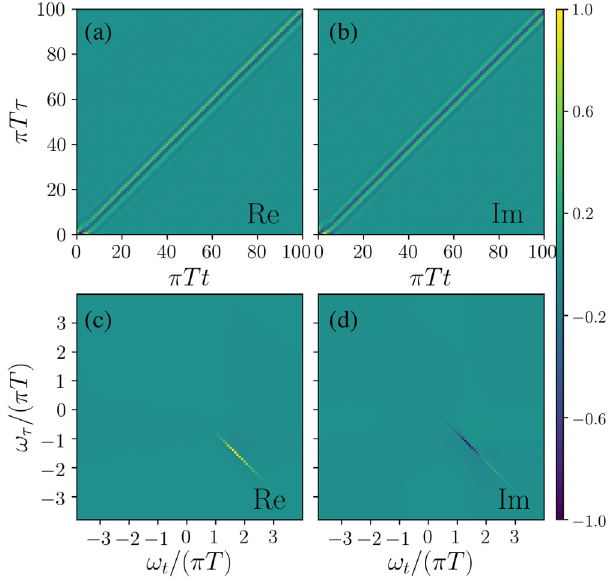
FIG. 5. (a),(b) The real and imaginary parts of the nonlinear ð 3 Þ magnetic susceptibility χ þ −− þ of an antiferromagnetic chain as a function of π Tt and π T τ . The Luttinger parameter K ¼ 1 . Magnetization density 2 mu=T ¼ 1 . 15 . The waiting time π Tt ¼ 1 . The data are scaled such that the maximum of the w absolute value of the data is 1. (c),(d) The real and imaginary parts of the two-dimensional